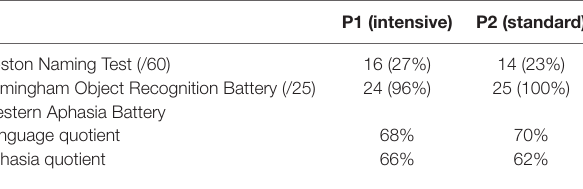
taBLe 1 | Inclusion screening measures before phonological components analysis